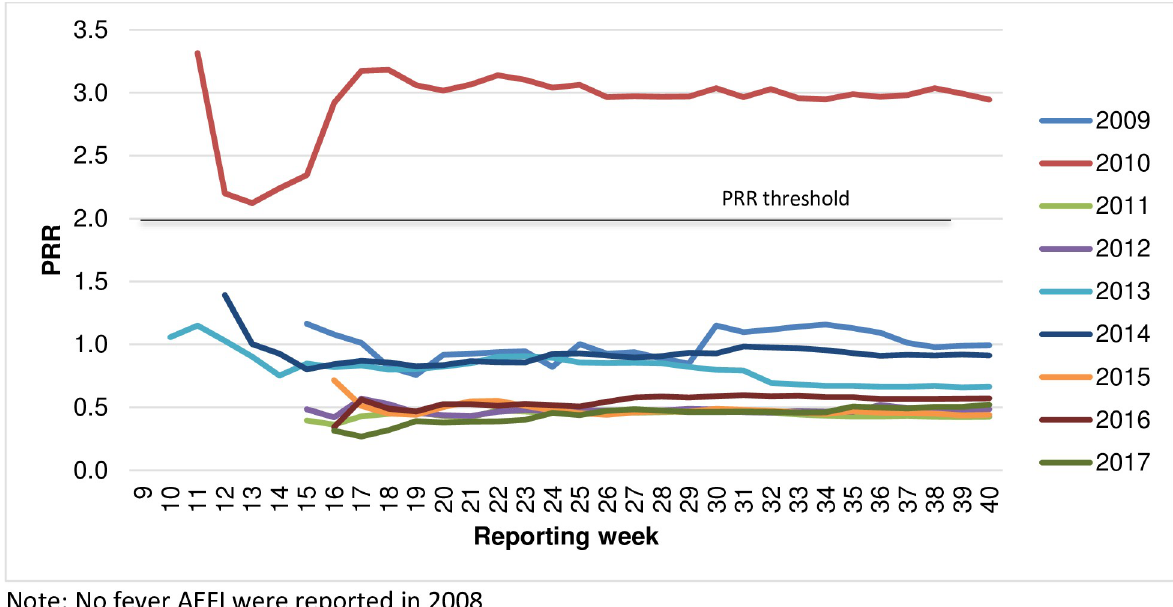
Fig 1. PRR cumulative (individual year) for Influenza vaccines and fever AEFI, by reported year and week, 2008–2017.